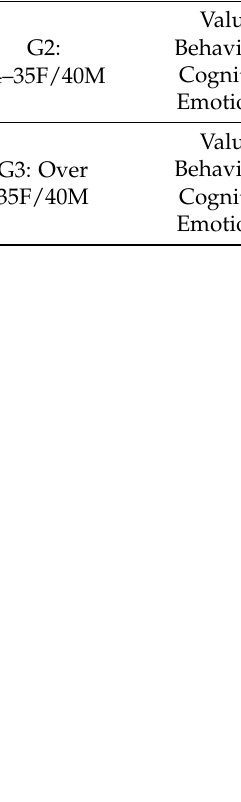
Table 9. Mean differences between groups for the Personal Autonomy Questionnaire (PAQ)